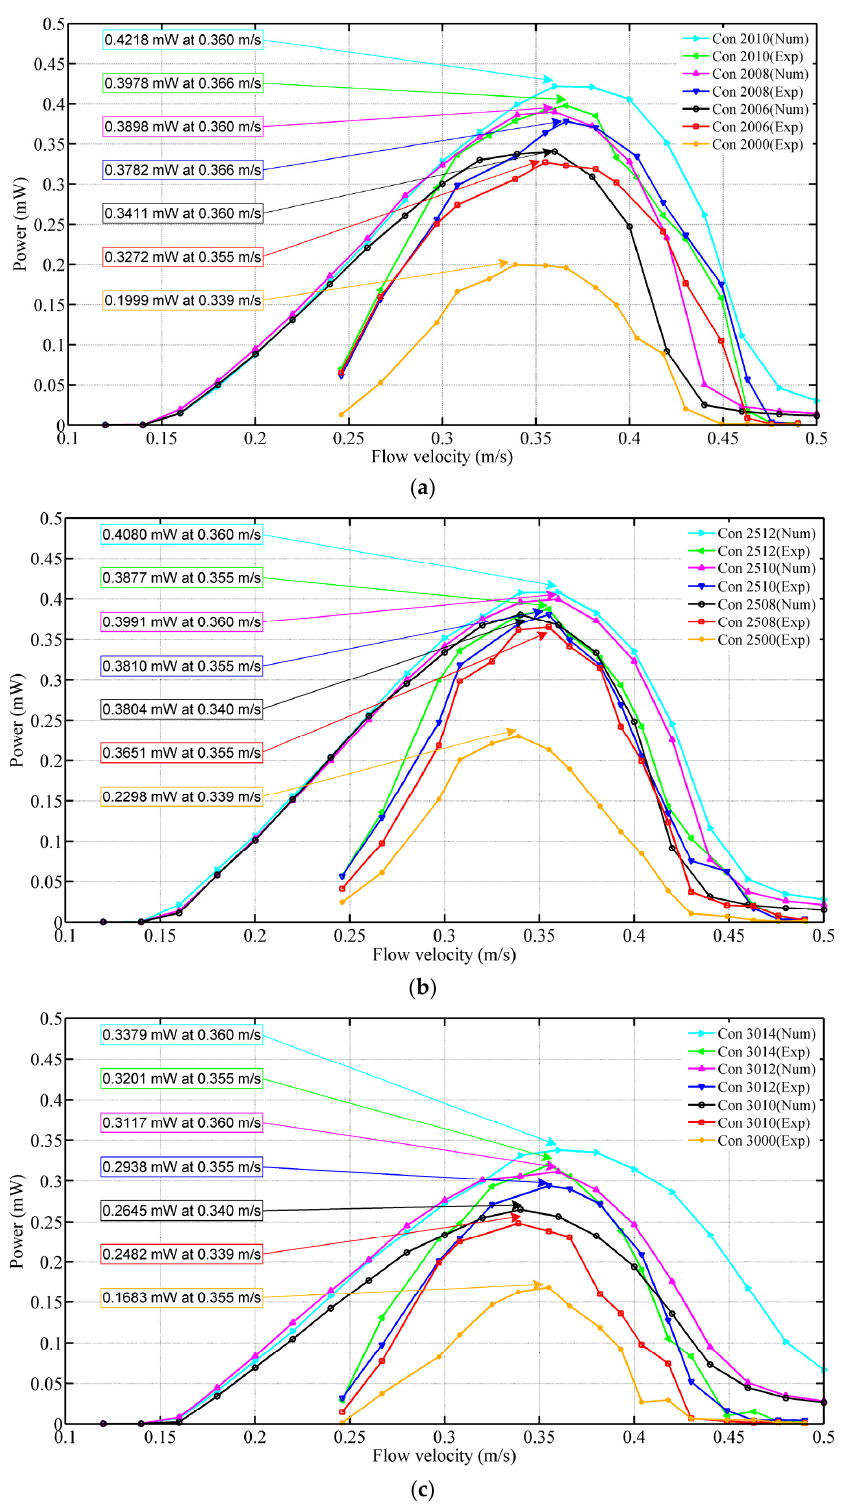
Figure 7. Values of average power numerically calculated and experimentally measured at various flow velocities with different cylinder configurations of energy harvesters with a beam width of 25